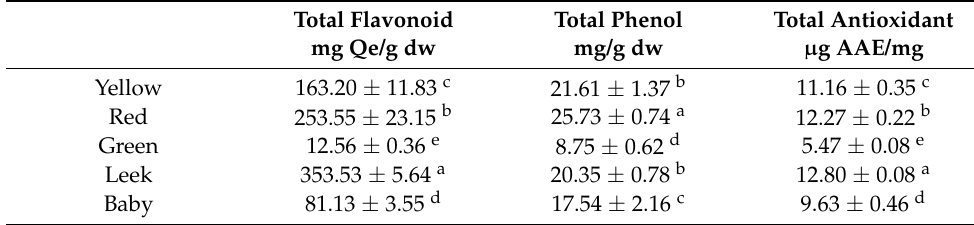
Table 1. Total flavonoid, phenol, and